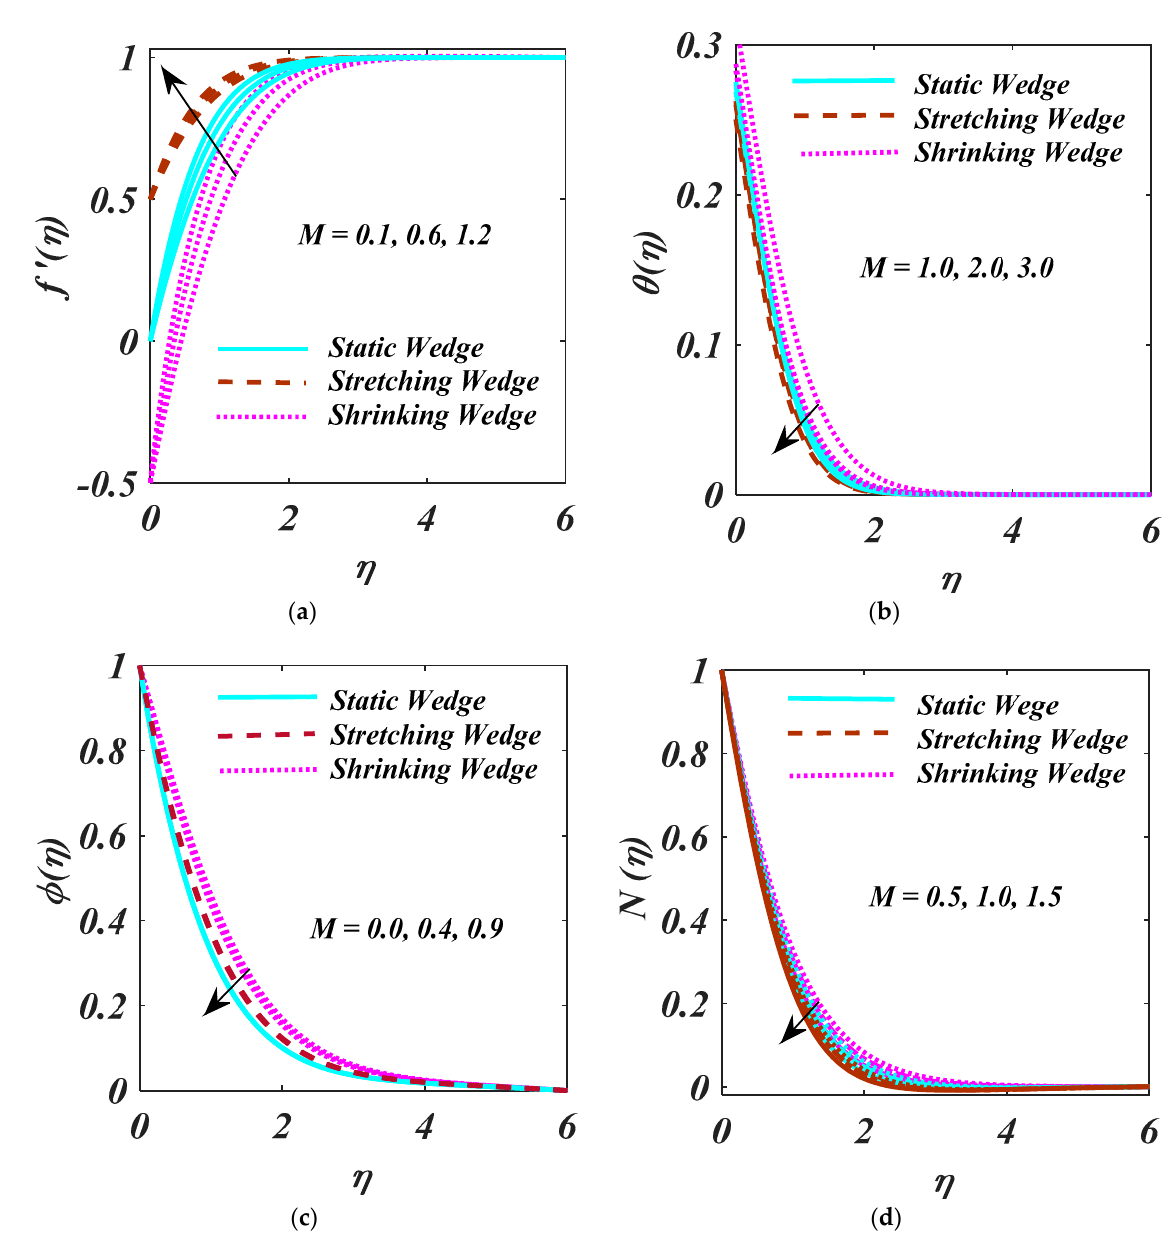
Figure 3. ( a , b ) (cid:1858)′(cid:4666)(cid:2015)(cid:4667) impact on (cid:1832)(cid:1870) and (cid:2018) . The characteristics of (cid:1839) on the (cid:1858) (cid:4593) (cid:4666)(cid:2015)(cid:4667) , (cid:1840)(cid:4666)(cid:2015)(cid:4667) (cid:2016)(cid:4666)(cid:2015)(cid:4667) , (cid:2038)(cid:4666)(cid:2015)(cid:4667) is demonstrated in Figure The characteristics of M on the f (cid:48) ( η ) , N ( η ) θ ( η ) , φ ( η ) is demonstrated in Figure 4a–d. 4a–d. Less velocity due to the larger values of (cid:1839) .The increment of M develops a strong Less velocity due to the larger values of M . The increment of M develops a strong Lorentz Lorentz force that decays the (cid:1858) (cid:4593) (cid:4666)(cid:2015)(cid:4667) . Furthermore, it is clear that ( (cid:2019) (cid:3408) 0 ) was as compared force that decays the f (cid:48) ( η ) . Furthermore, it is clear that ( λ > 0) was as compared with with ( (cid:2019) (cid:3404) 0 ), and ( (cid:2019) (cid:3407) 0 ). Augmention in M on (cid:2016)(cid:4666)(cid:2015)(cid:4667) as seen in Figure 4b. The variation ( λ = 0), and ( λ < 0). Augmention in M on θ ( η ) as seen in Figure 4b. The variation of of magnetic factor on (cid:2038)(cid:4666)(cid:2015)(cid:4667) and (cid:1840)(cid:4666)(cid:2015)(cid:4667) is employed in Figure 4c,d. The leading value of magnetic factor on φ ( η ) and N ( η ) is employed in Figure 4c,d. The leading value of M , (cid:1839) , both the (cid:2038)(cid:4666)(cid:2015)(cid:4667) , and (cid:1840)(cid:4666)(cid:2015)(cid:4667) . The boiling liquid moves downstream as the velocity ratio both the φ ( η ) , and N ( η ) . The boiling liquid moves downstream as the velocity ratio rises, rises, bringing the fluid’s temperature down (see Figure 4b). bringing the fluid’s temperature down (see Figure 4b).